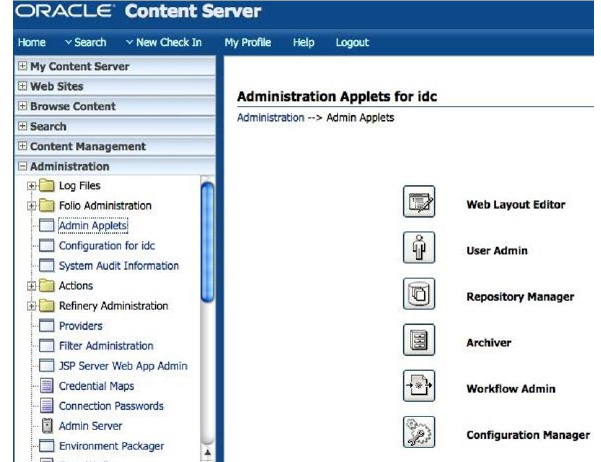
Fig. 2 . Friendly user interface of UCM